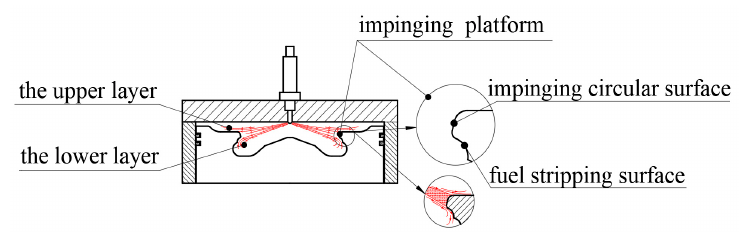
Figure 1. Basic schematic diagram of the double-layer diverging combustion (DLDC) chamber.